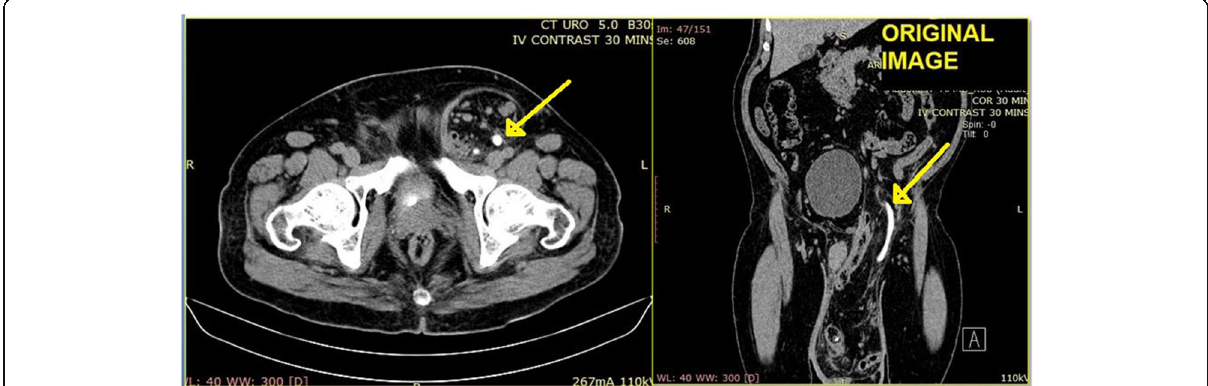
Fig. 2 CT urography shows hernia sac in left inguinal region with opacified ureter, in axial and coronal